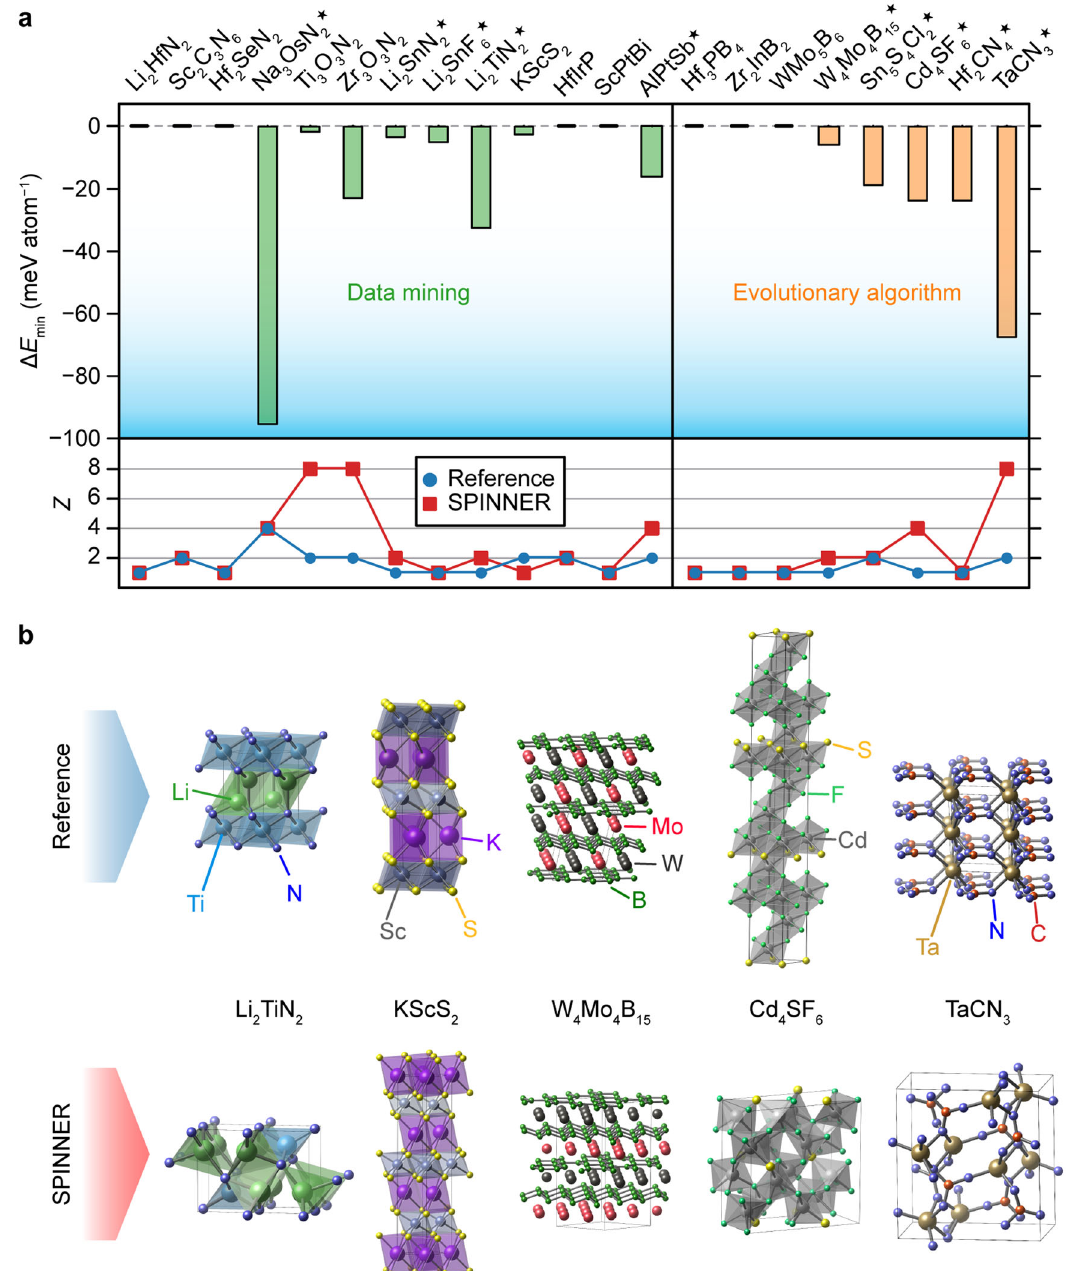
Fig. 3 Benchmark results of SPINNER against other methods. a Upper part shows energy difference between the structure predicted by SPINNER and the reference structure ( Δ E min ) predicted by data mining or evolutionary algorithms. The lower part compares the formula unit in the unit cell ( Z ) between the reference and the value at which the lowest energy is found by SPINNER. The structures are adopted from ref. 13 (Li 2 HfN 2 , Sc 2 C 3 N 6 , Hf 2 SeN 2 , Na 3 OsN 2 ), ref. 59 (Ti 3 O 3 N 2 , Zr 3 O 3 N 2 ), ref. 60 (Li 2 SnN 2 , Li 2 SnF 6 , Li 2 TiN 2 ), ref. 61 (KScS 2 ), ref. 16 (HfIrP, ScPtBi, AlPtSb), ref. 62 (Hf structures in references (top) and ones identi fi ed by SPINNER